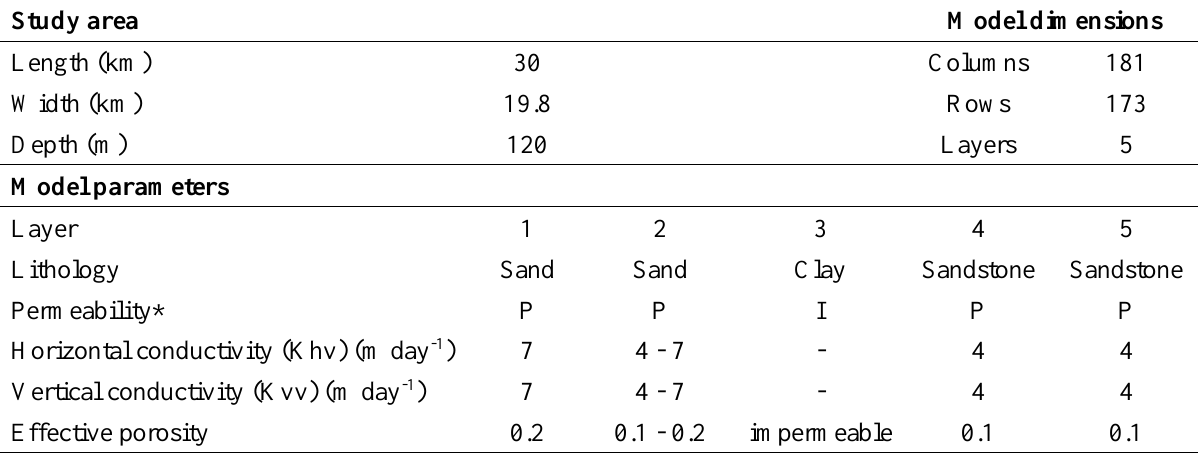
Table 1. Model dimensions and layer parameters. Study